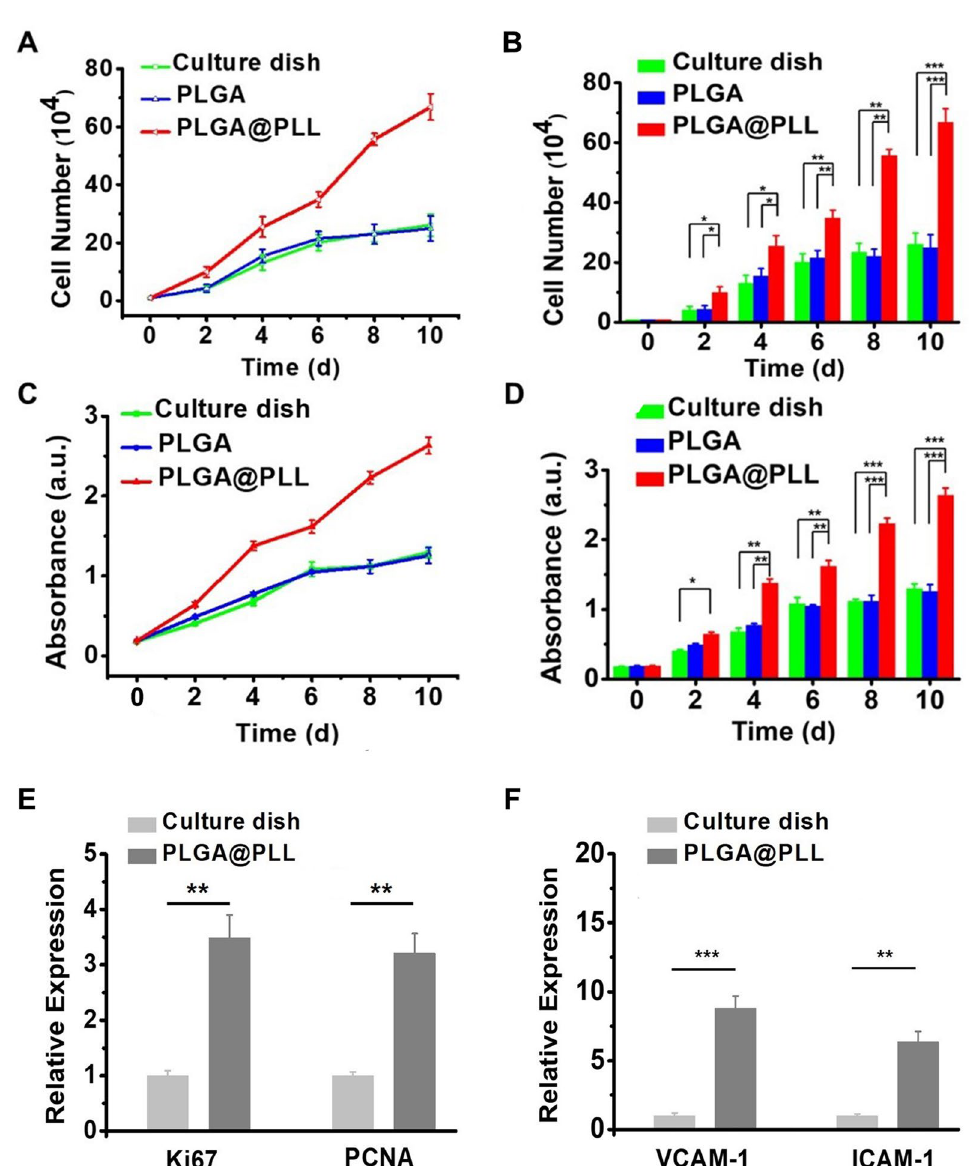
Fig. 2 Cell proliferation was evaluated by cell counting and CCK-8 assay. A Cell growth curves of three groups, including culture dish, PLGA scaffold, and PLGA@PLL scaffold, were made according to cell counting. B Statistical analysis of cell proliferation according to CCK-8 assay ( n growth curves of hUC-MSCs seeded on the culture dish, PLGA scaffold, and PLGA@PLL scaffold were made based on cell counting. D Statistical analysis of cell proliferation based on CCK-8 assay ( n 6). E Expression levels of the Ki67 and PCNA genes among the control and the scaffold = groups were compared ( n 5). F Expression levels of the VCAM-1 and ICAM-1 genes among the control and the scaffold groups were compared = ( n 5). The data were normalized to the internal control β-actin and are plotted. *indicates p < 0.05, **indicates p < 0.01, ***indicates p < 0.001, = two-tailed